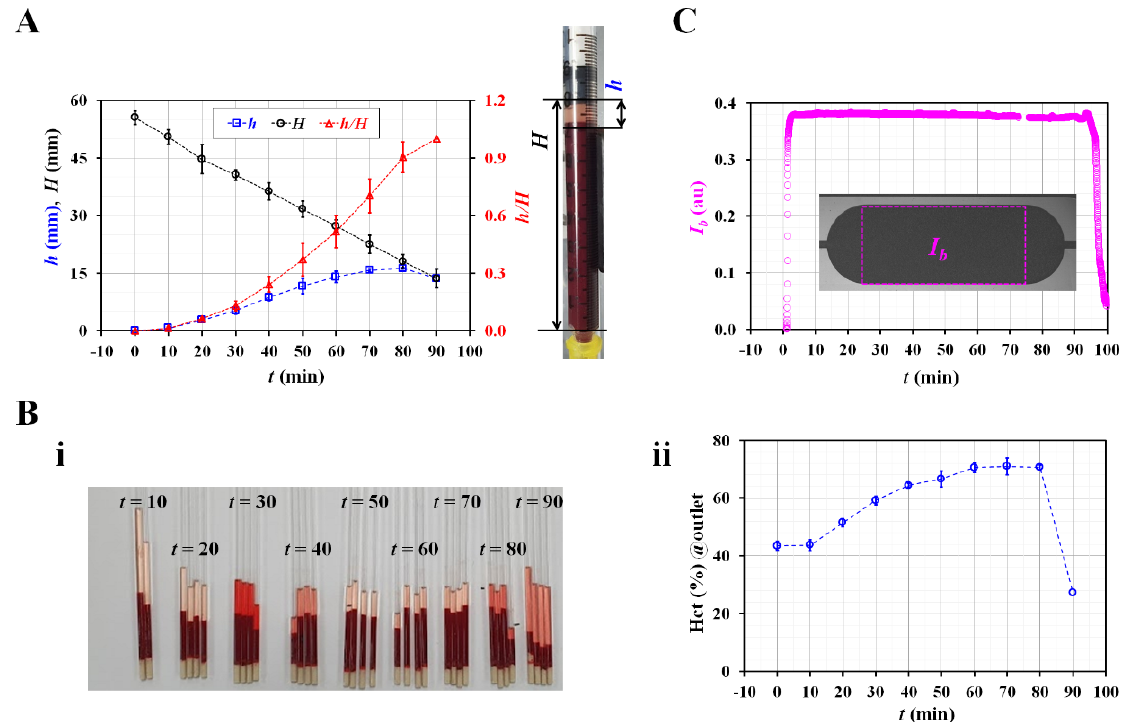
Figure 3. Quantification of RBC sedimentation in terms of three representative factors (i.e., sedimen- tation distance, hematocrit, and image intensity). ( A ) Temporal variations of RBC sedimentation distance in blood syringe. Right-side panel shows diluent height ( h ) as well as blood height ( H ). ( B ). Measurement of hematocrit with hemocytometer. (i) Capillary tubes captured after operation of micro hemocytometer. (ii) Temporal variations of hematocrit of blood collected at outlet. ( C ) Tem- poral variation of image intensity ( I b ) in blood channel.